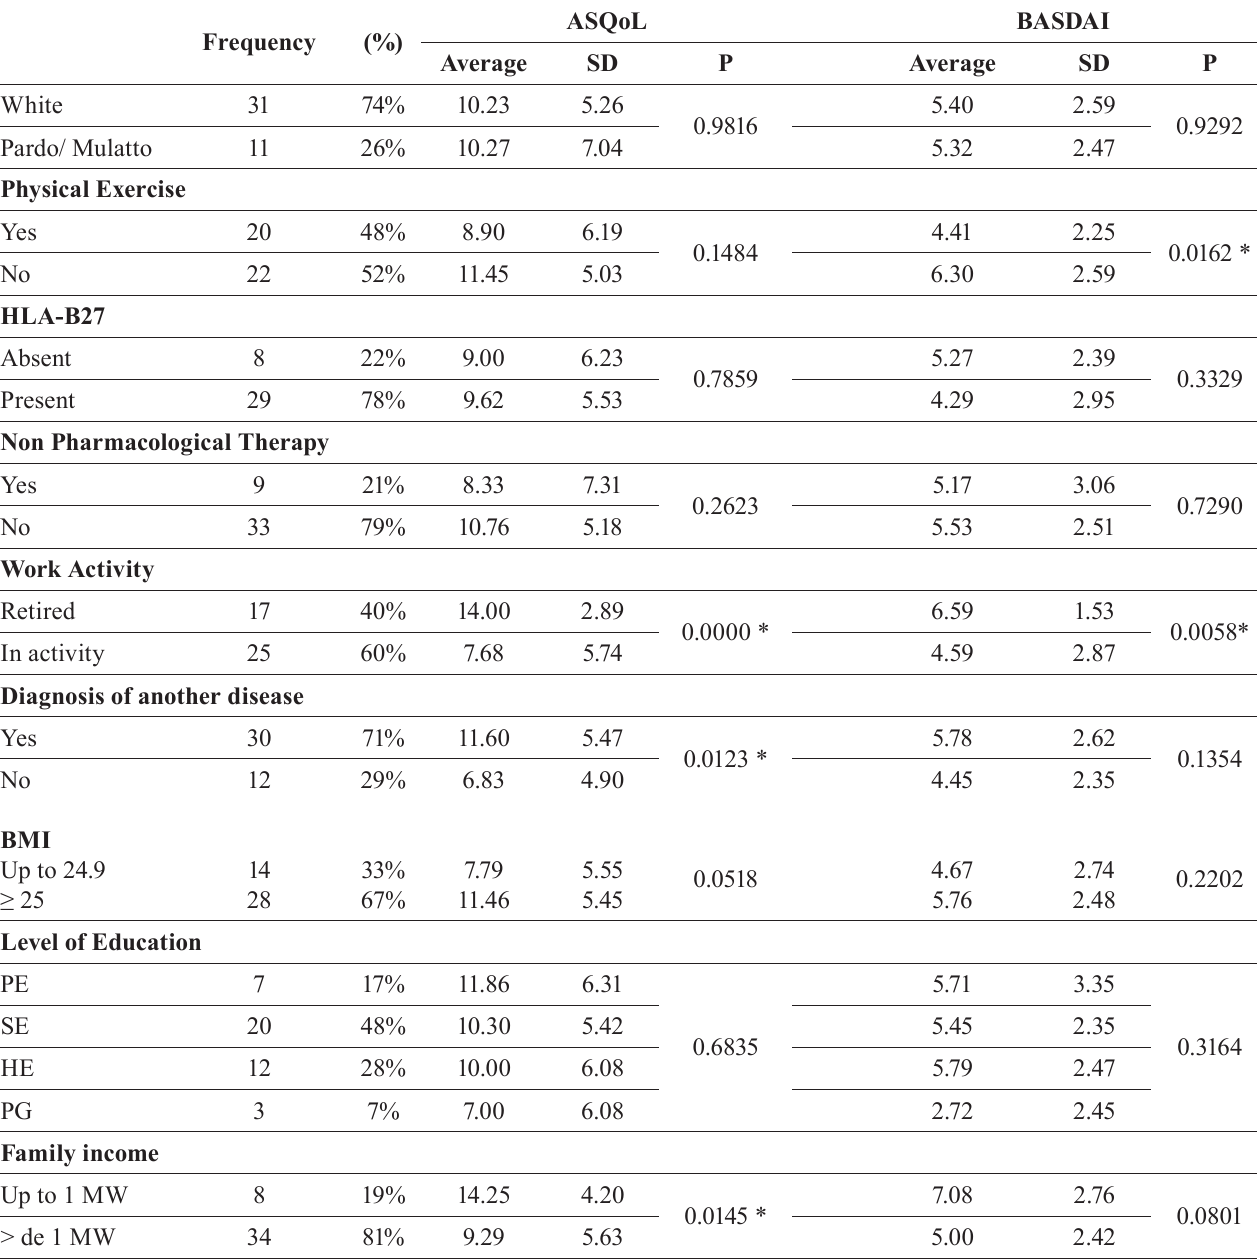
TABLE II – Frequency distribution and analysis of variance for the ASQoL and BASDAI indexes, according to demographic